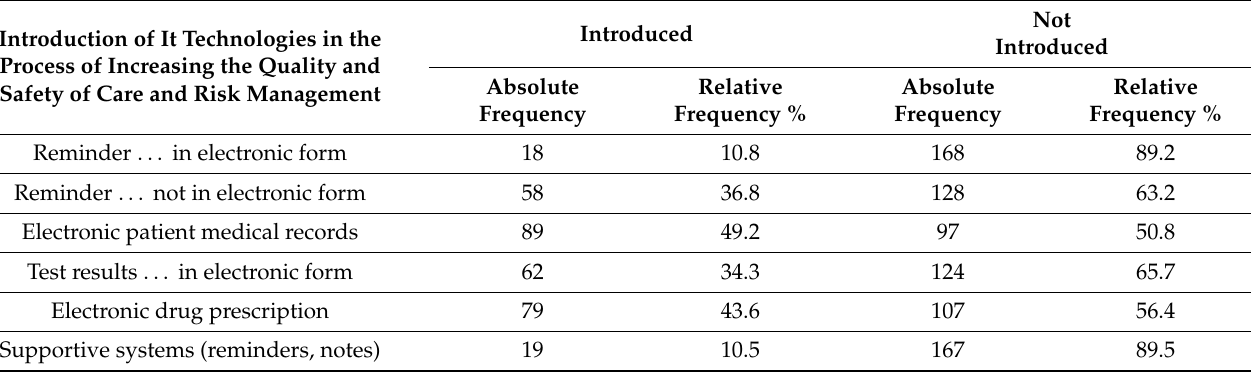
Table 6. Introduction of IT technologies in the process of increasing the quality and safety of care and risk management.